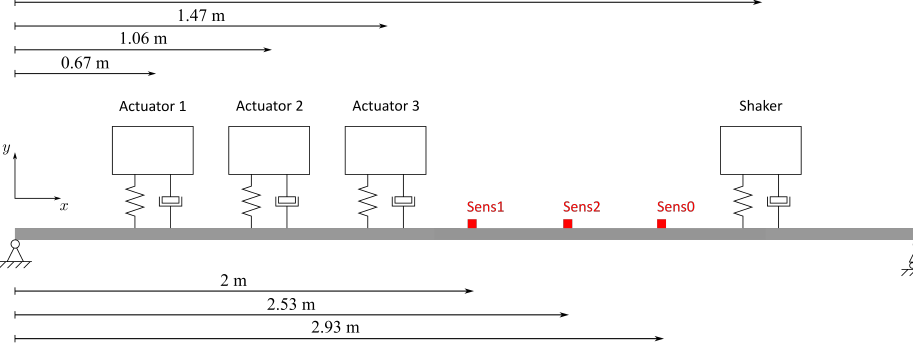
Figure 4. Position of actuators and sensors on the test